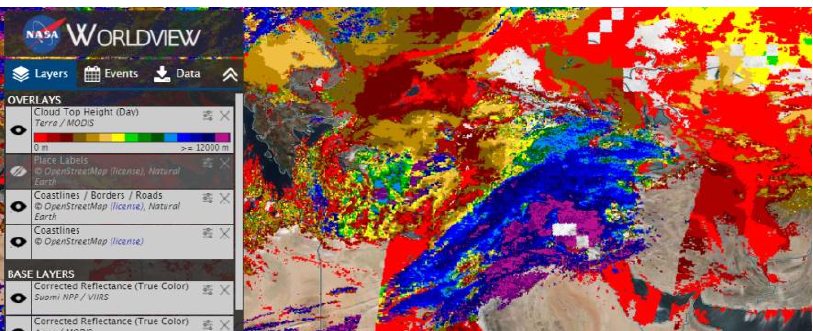
Fig.13: Indicate the height of cloud in purple color over middle and most of south Iraq (12000 m)